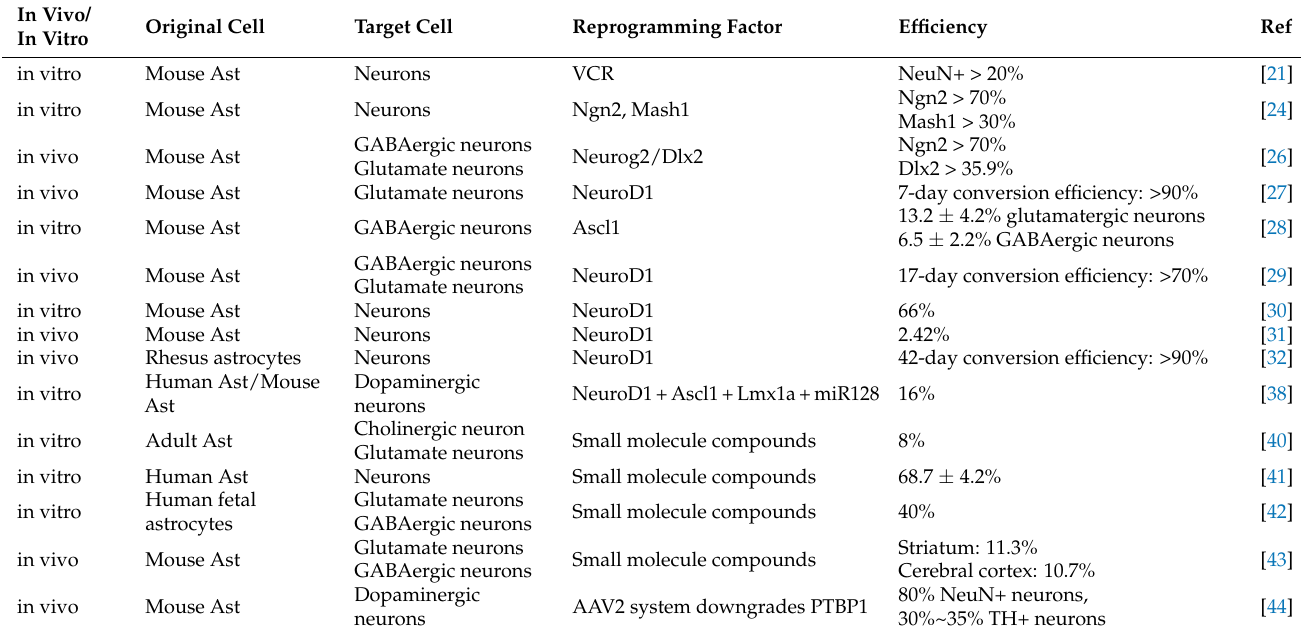
Table 1. Astrocyte